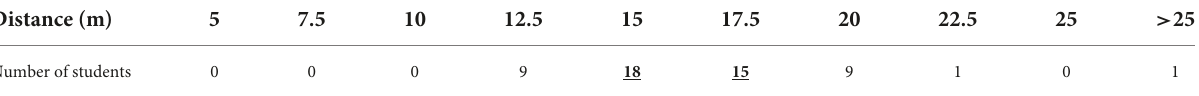
TABLE 1 Distribution of students according to the distance swum. Distance